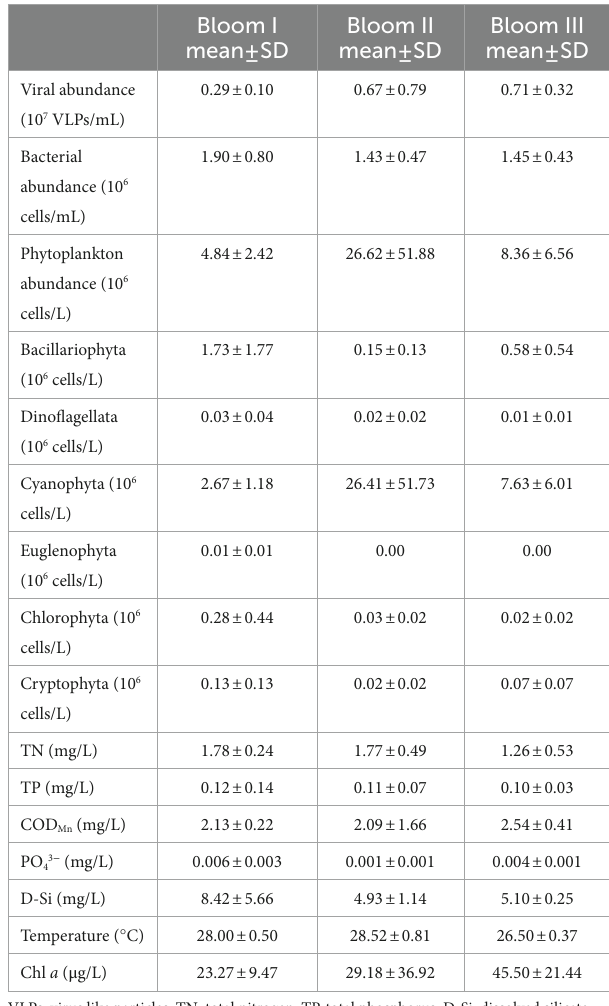
TABLE 1 Mean (±SD) microbial and environmental characteristics of the summer bloom succession in Xiangxi Bay from 18th July to 29th August 2017.